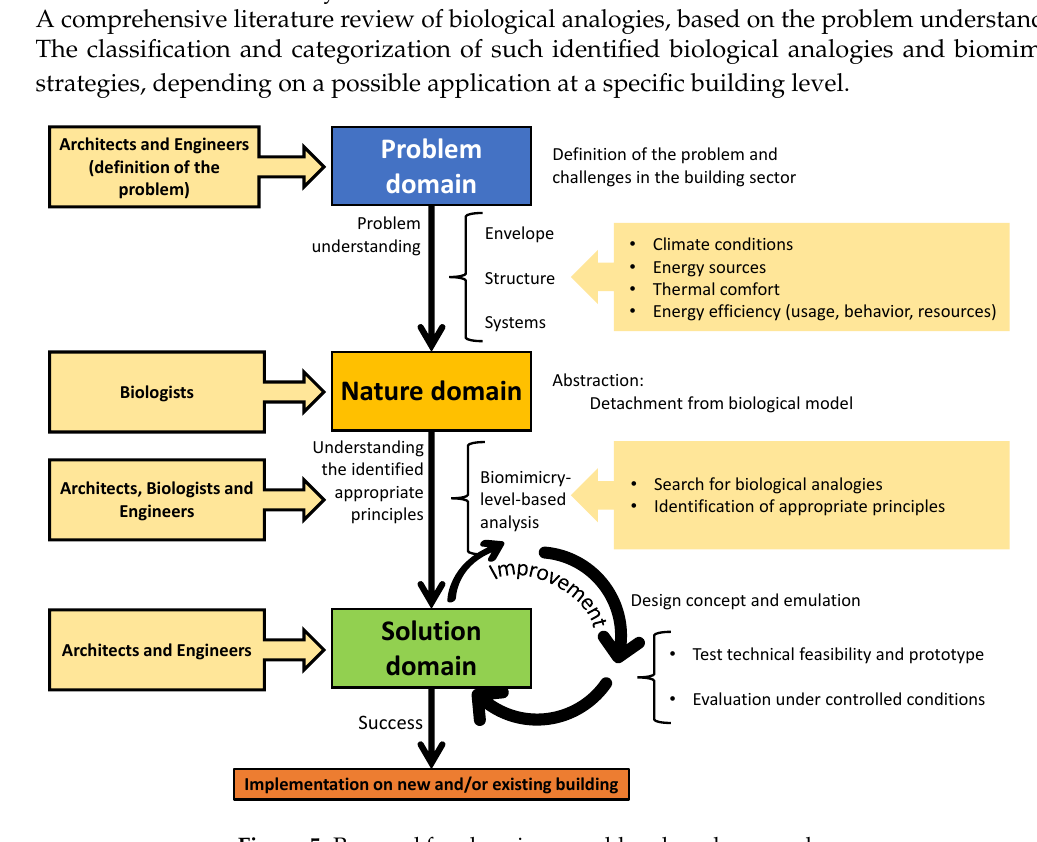
Figure 5. Proposal for choosing a problem-based